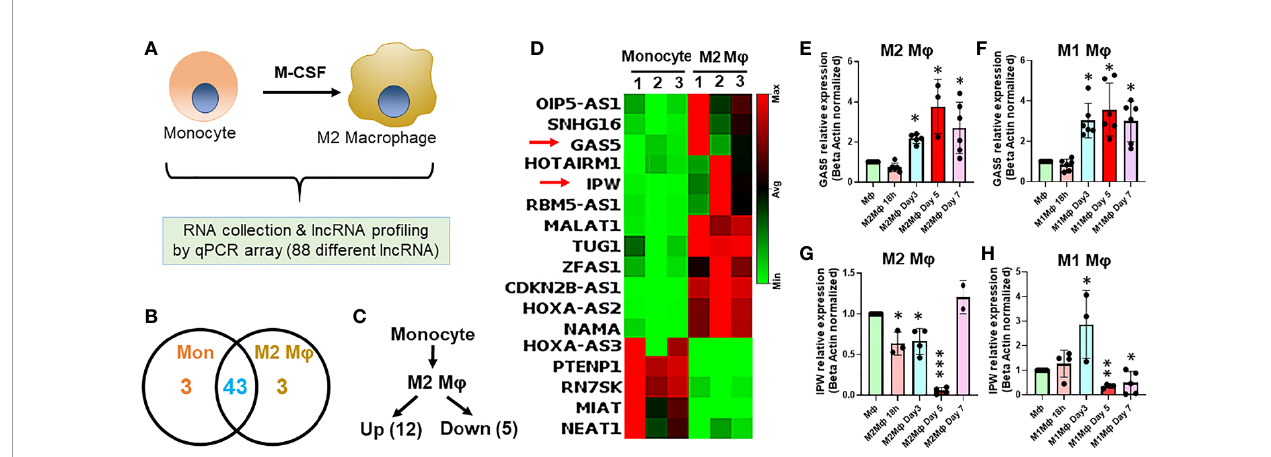
FIGURE 1 | Differential expression of lncRNAs occurs in monocyte-derived macrophages. (A) Schematics of the experimental design to evaluate lncRNA pro fi les. (B) Venn diagram summarizing differentially expressed lncRNAs genes in monocyte and day 7 differentiated M2 macrophages. Corresponding numbers in left and right elucidate the lncRNA identi fi ed in either monocytes or M2 M j . The number depicted in the overlapping region shows the number of lncRNAs expressed in monocytes and M2 M j . (C) Number of signi fi cantly up- and downregulated lncRNAs in M2 M j compared to monocytes. LncRNAs with fold-change ≥ 2 were considered differentially expressed. (D) Heat map based elucidation of lncRNAs showing differential expression pattern in monocytes and M2 M j . The numbers on the top of the heat map show the monocytes isolated from three donors for M2 M j conversion. (E − H) Time kinetics of GAS5 and IPW expression in M1 and M2 M j with respect to monocytes using RT-qPCR. Data were normalized with b -actin as a housekeeping control. Each bar is representative of at least three different experiments and represents the mean ± standard deviation. Two-tailed t-test was used to evaluate statistical signi fi cance. *P < 0.05, **P < 0.01, ***P < 0.001